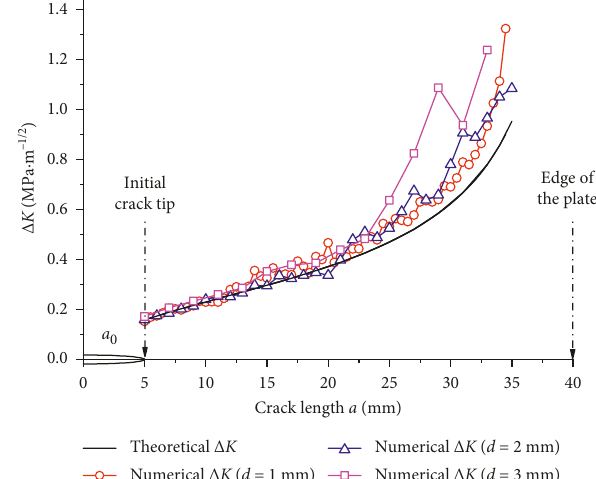
Figure 17: Comparison of the range of stress intensity factor calculated using numerical and theoretical methods for different crack lengths a ( a 0 5 mm) and particle diameters d . (cid:31)